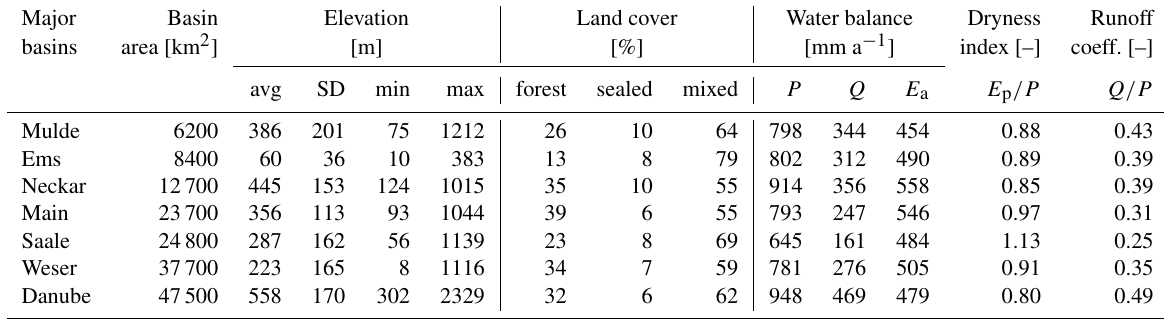
Table 1. Basin properties and water balance characteristics of the seven major German river basins. The geographical location of the basins is depicted in Fig. 1. Abbreviations: avg – average, SD – standard deviation, min – minimum, max – maximum, P – precipitation, Q